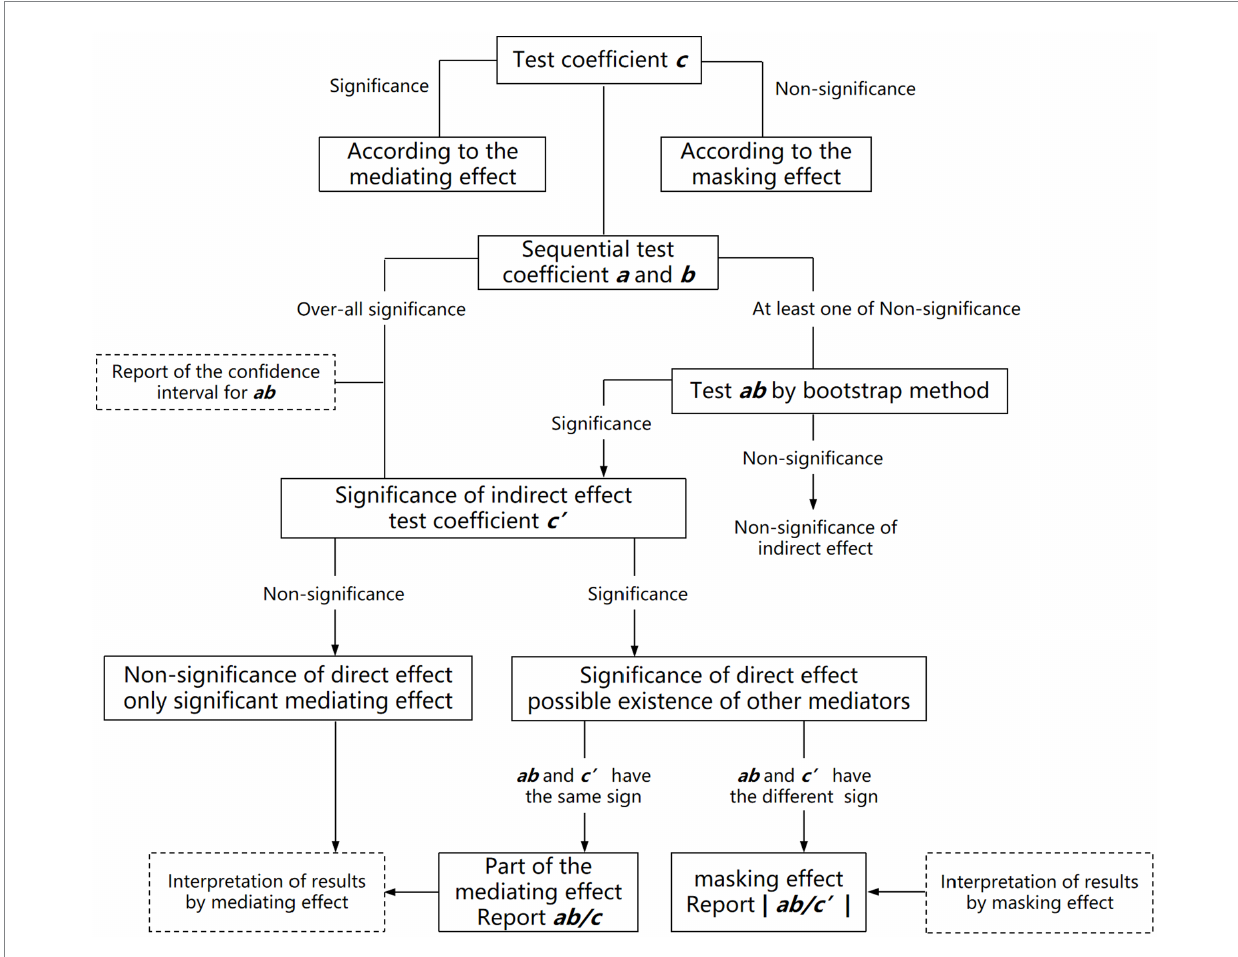
FIGURE 5 Test process of mediation effects (61). Coefficient c : the total effect of an independent variable on a dependent variable; Coefficient a : the effect of an independent variable on a mediating variable; Coefficient b : the effect of a mediating variable on a dependent variable after the influence of the independent variable is controlled; Coefficient c ’: the direct effect of an independent variable on a dependent variable after the influence of the mediating variable is